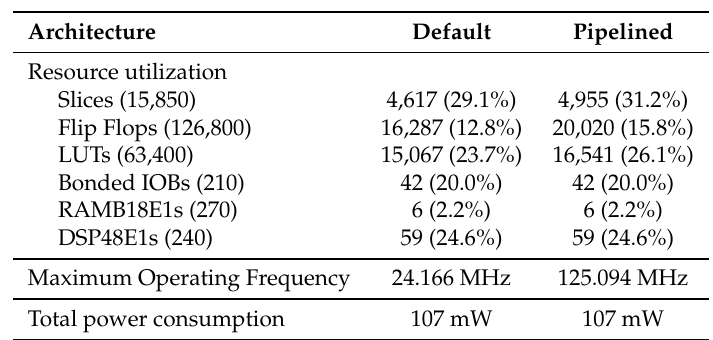
Table 1. Resource utilization, maximum operating frequency, and total power consumption obtained for the Artix-7 XC7A100T chip. LUT: Look-Up Table; IOB: Input/Output